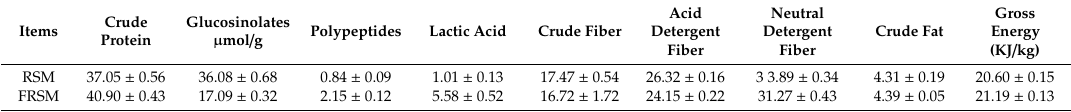
Table 1. Chemical composition of fermented rapeseed meal (FRSM) and rapeseed meal (RSM) used in this study (%, dry matter